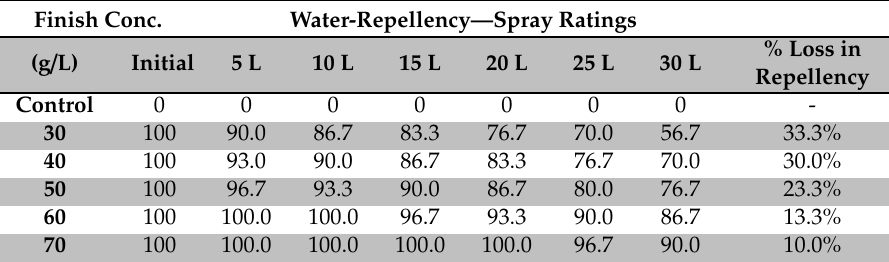
Table 2. E ff ect of laundering on Water-repellency (spray test) of polyester / cotton. Table 2. Effect of laundering on Water-repellency (spray test) of polyester/cotton. Finish Conc. Finish Conc.